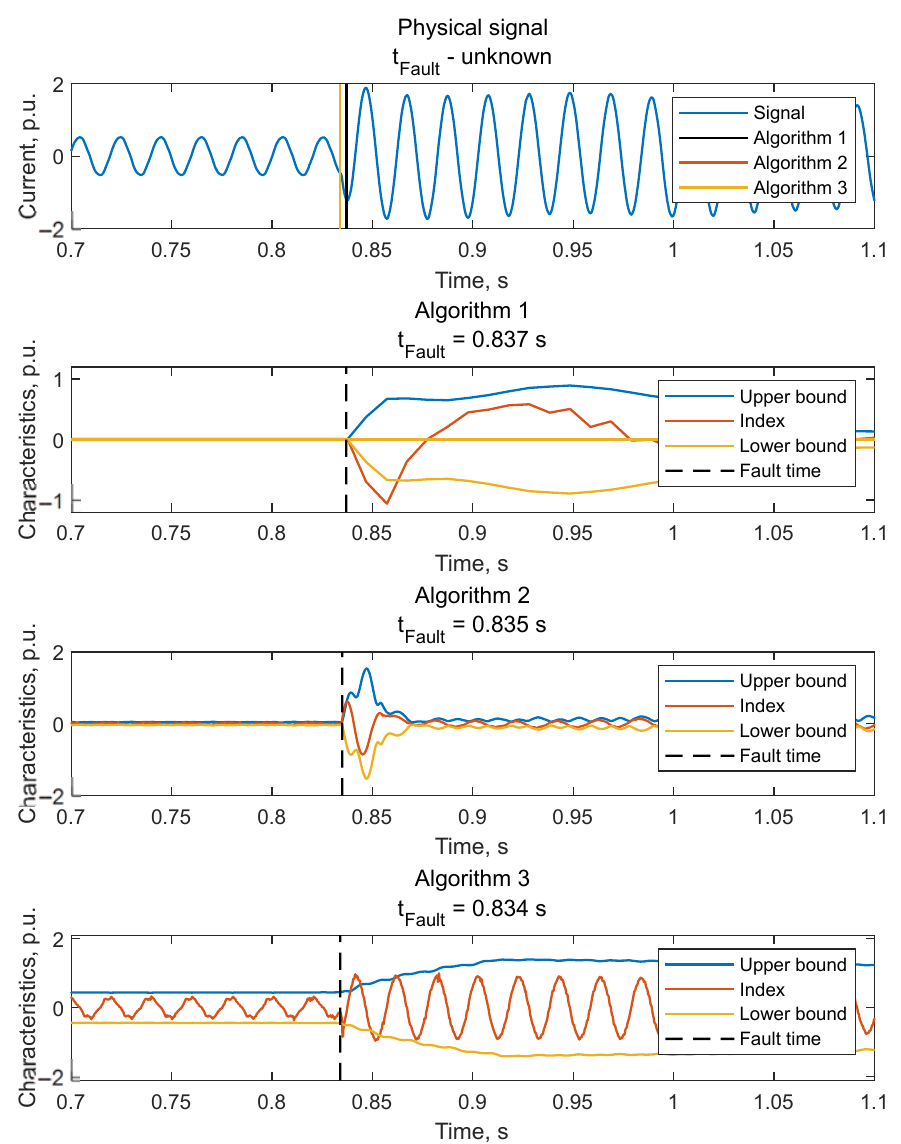
Figure 9. Results of inception time detection for the physical signal.